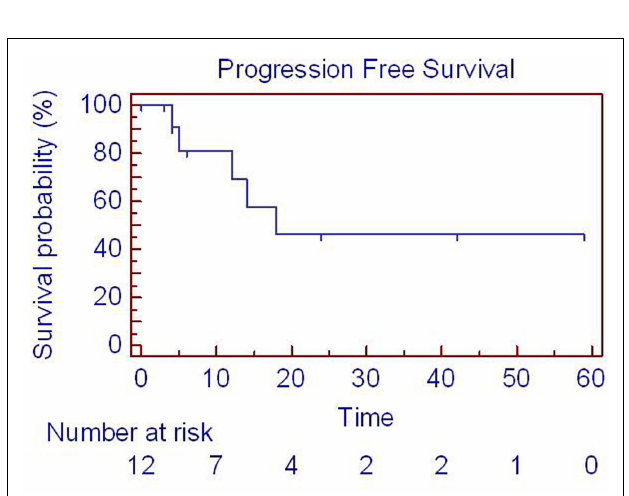
FIGURE 2 | Locoregional control for patients with parotid tumors treated with SBRT. One patient died on treatment at time 0, so 12 patients are represented. SBRT = stereotactic body radiation treatment.